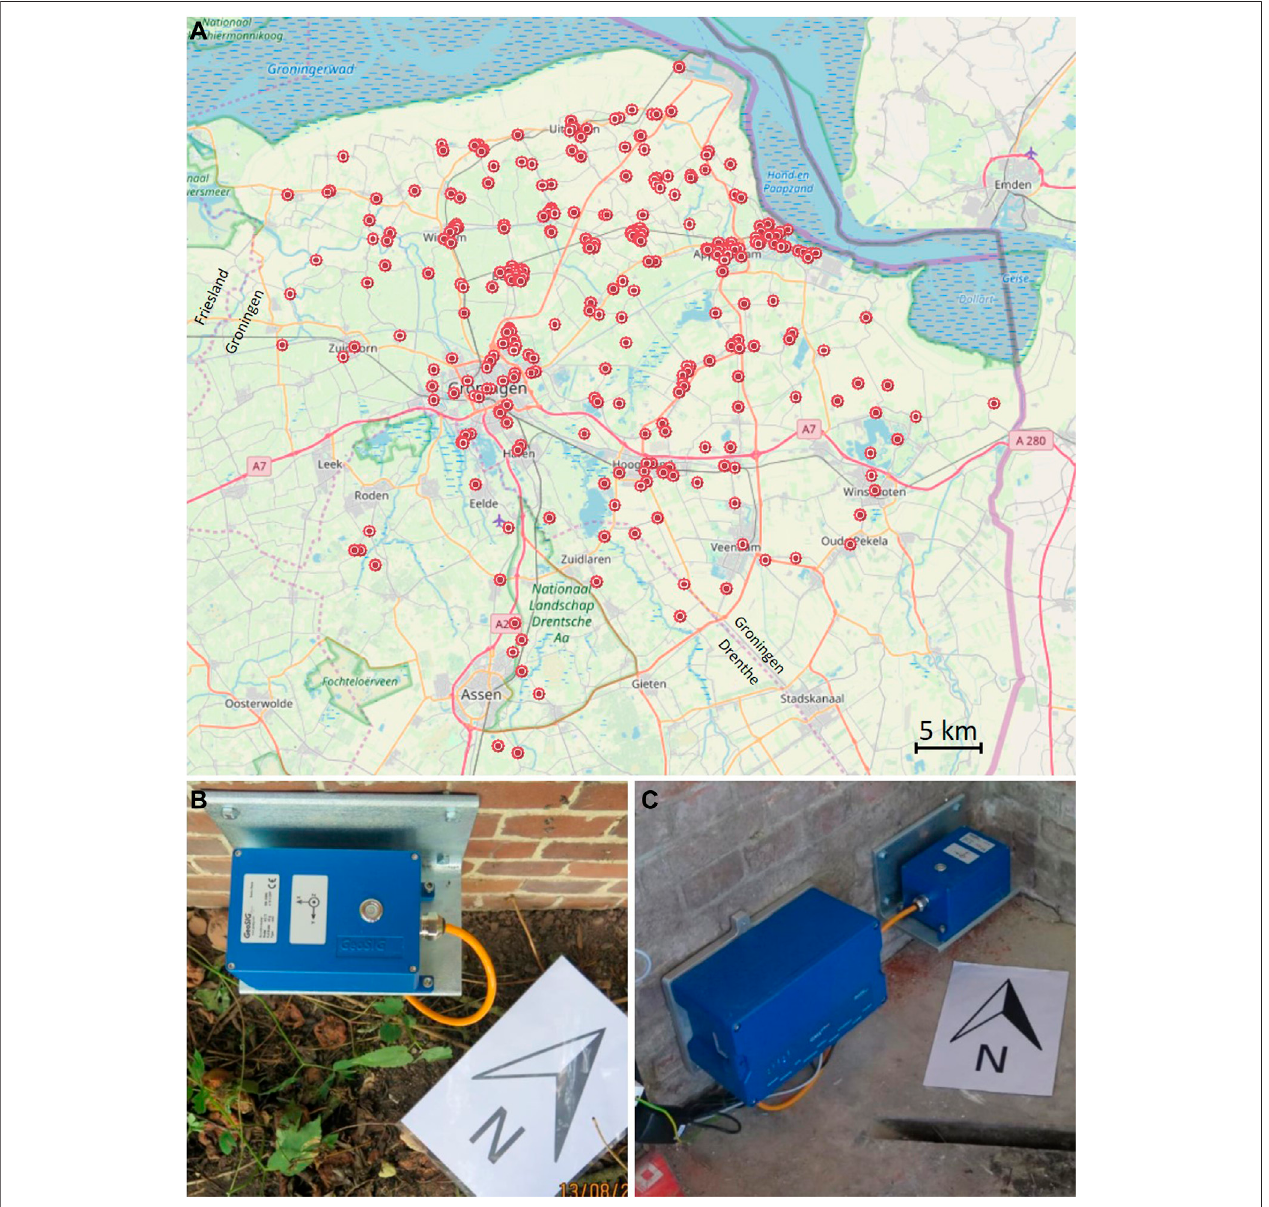
FIGURE1|(A) Building locations in the vibration monitoring network in the province of Groningen. Geosig sensors near a stiff corner on (B) the outside and (C) the inside of a building. The large blue box is the recorder, the small blue box is the sensor.